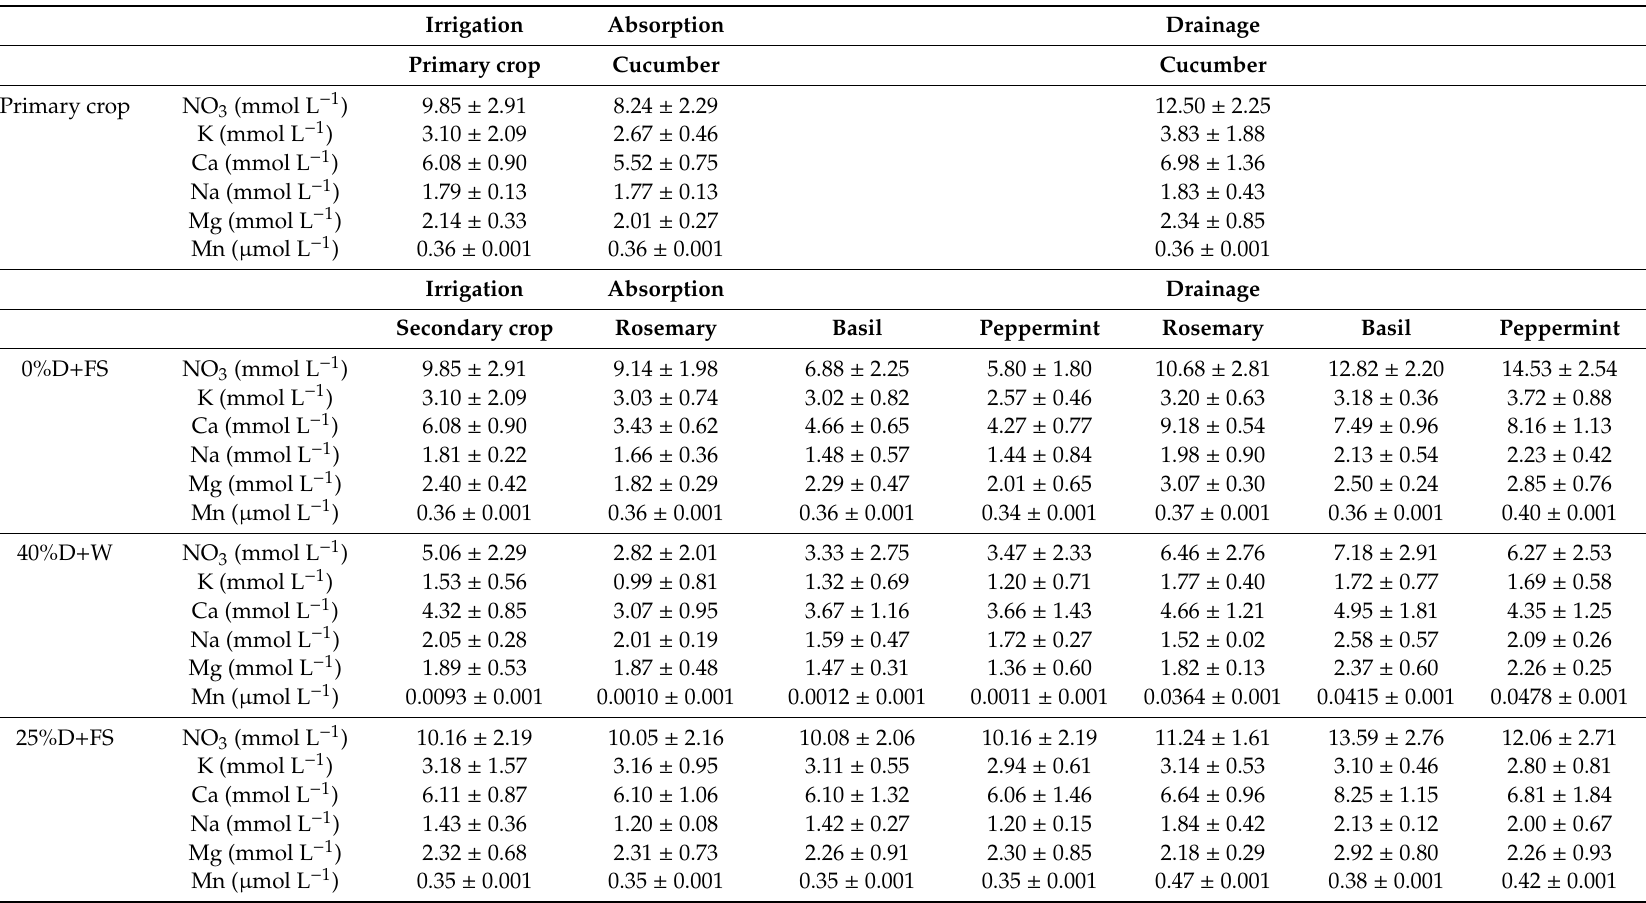
Table 2. Mean values (and standard deviation) of elemental concentrations expressed in mmol L − 1 in irrigation and drainage solutions for primary and secondary crops according to the fertigation treatment during the 1st